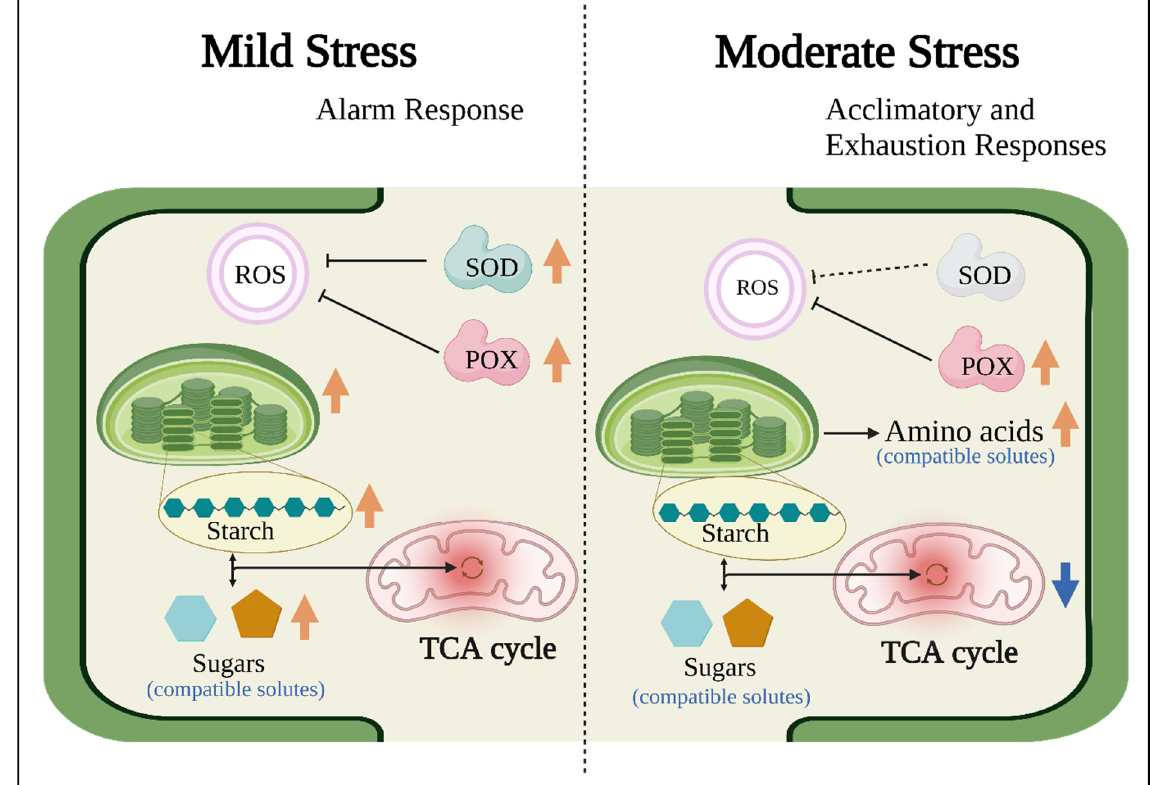
Figure 7. A Schematic comparing mild salinity stress and moderate salinity stress responses of gac plant. Figure is based on data generated in this study.